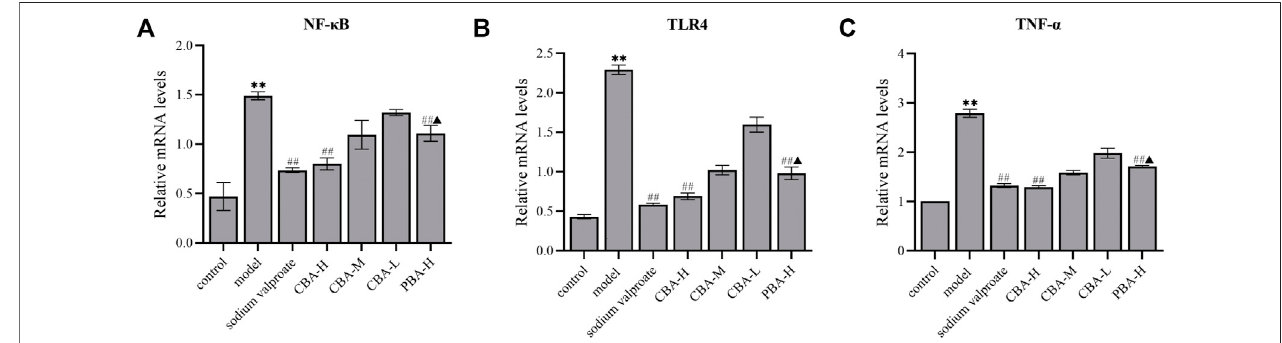
FIGURE 6| CBA suppressed the mRNA expression of NF- κ B (A) , TLR4 (B) , and TNF- α (C) in the hippocampus ofFS rat model. (A) The mRNA expression of NF- κ B in the hippocampus; (B) The mRNA expression of TLR4 in the hippocampus; (C) The mRNA expression of TNF- α in the hippocampus.